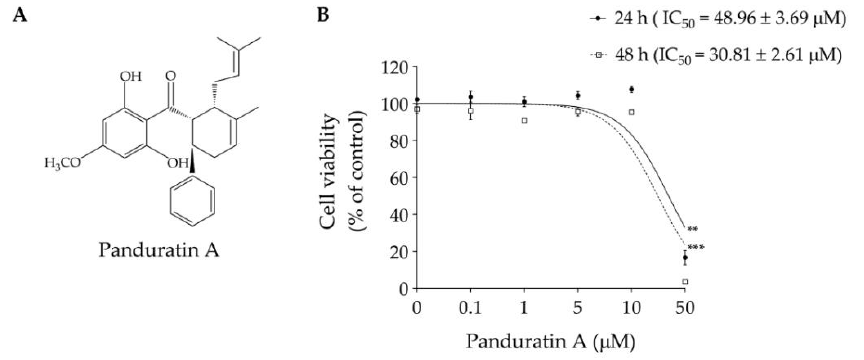
Figure 1. Cytotoxic potency of panduratin A in SIMA9 cells. ( A ) The chemical structure of panduratin A isolated from Boesenbergia rotunda ; ( B ) viability of SIMA9 cells after exposure with various concentrations of panduratin A for 24 h (solid line) and 48 h (dashed line). Statistical analysis was performed using linear regression analysis to obtain the IC 50 value of panduratin A in each time treatment. ** p < 0.01 and *** p < 0.001 compared to control (untreated cells).